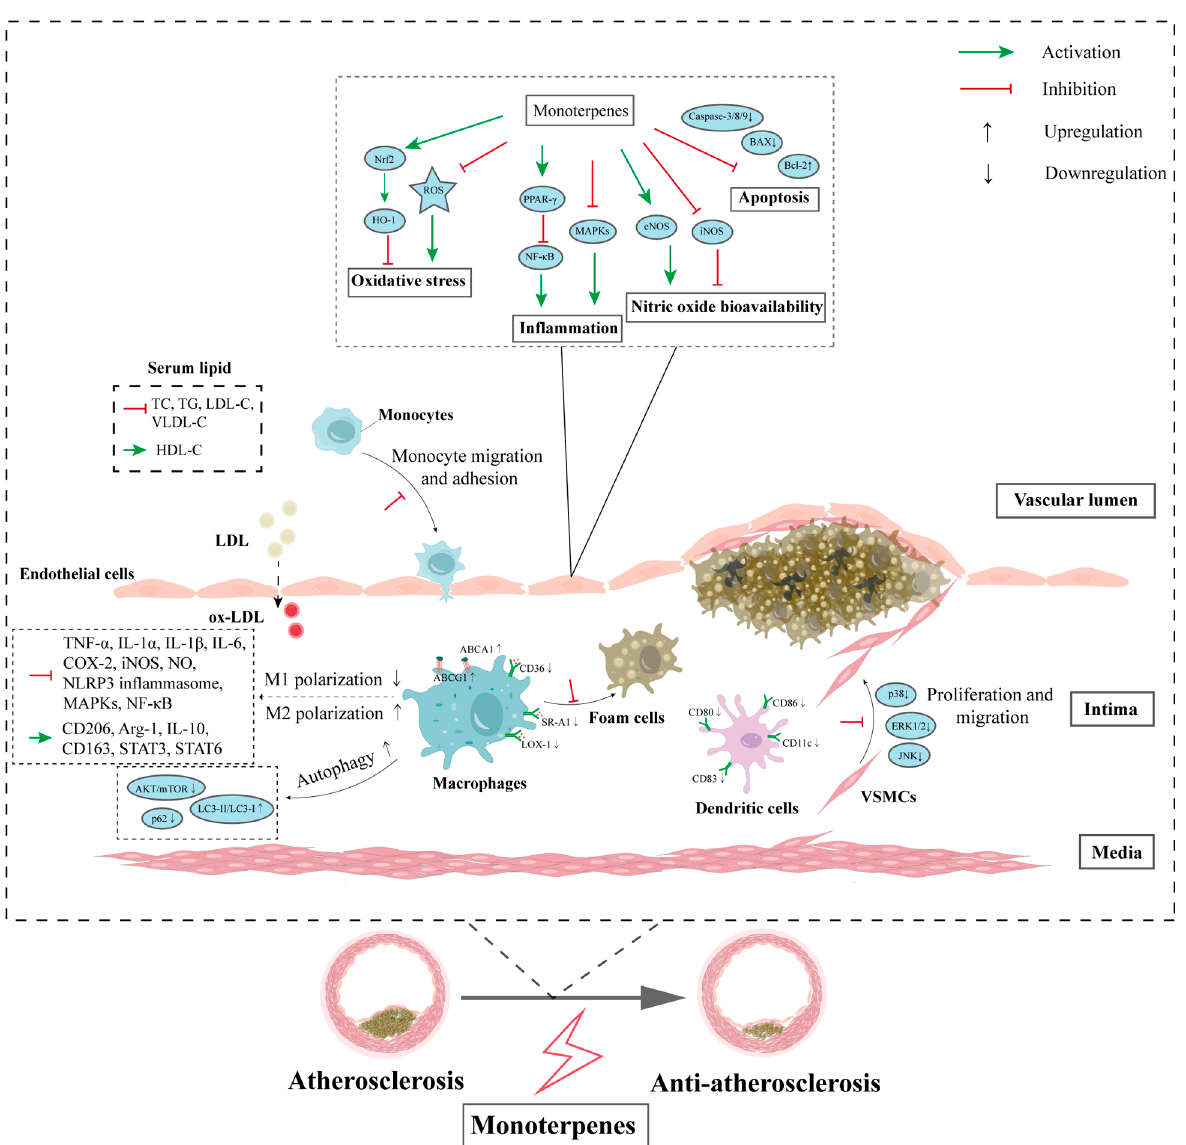
Figure 3. The cellular and molecular mechanisms of natural monoterpenes in the development of atherosclerosis. Monoterpenes target various pro-atherogenic factors and intracellular molecular pathways in atherogenesis-related cell types, thus leading to the attenuation of atherosclerosis.